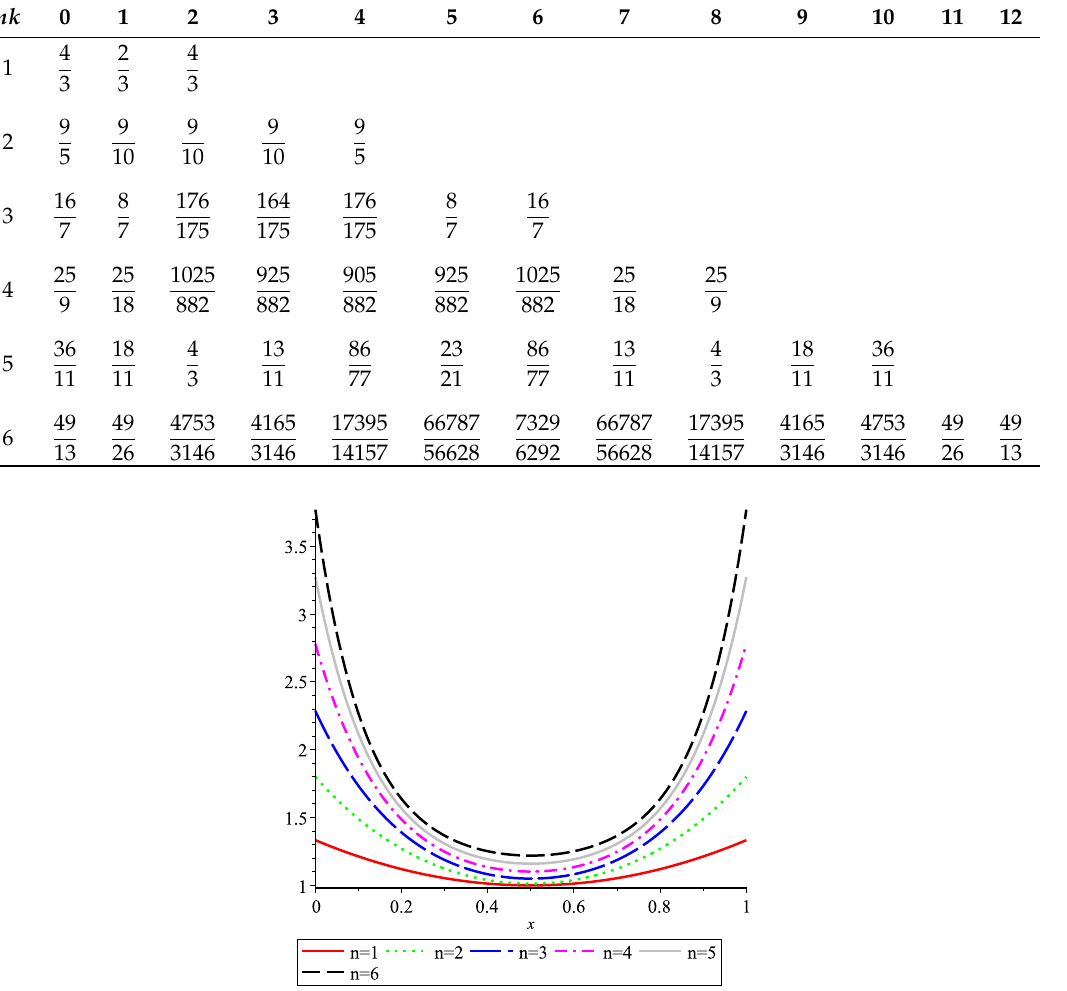
Table 1. Values of the coefficients q n , k .